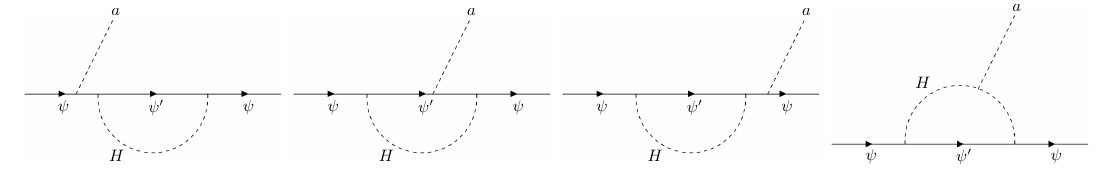
Figure 1 . Diagrams for the Yukawa-induced renormalization group running of c ψ